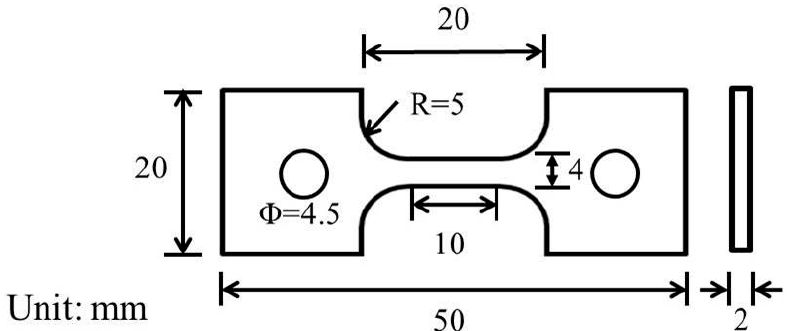
Figure 3. Dimensions of tensile test specimen.